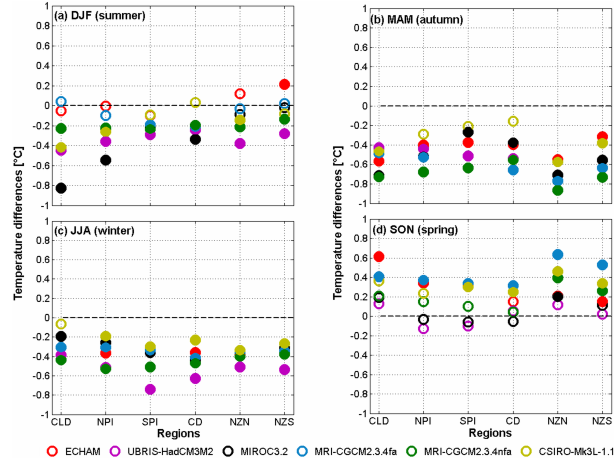
Figure 2. Temperature differences: mid-Holocene minus pre- industrial, over the six zones of analysis. (a) DJF, (b) MAM, (c) JJA, and (d) SON. Filled circles correspond to statistically significant differences ( p ≤